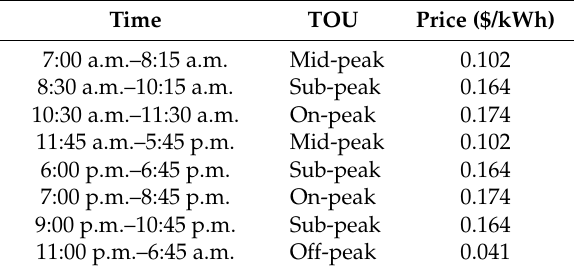
Figure 4. Daily hot water demands and rigid electrical demands for a single residential consumer. Table 1. Time-of-use (TOU) electricity prices.